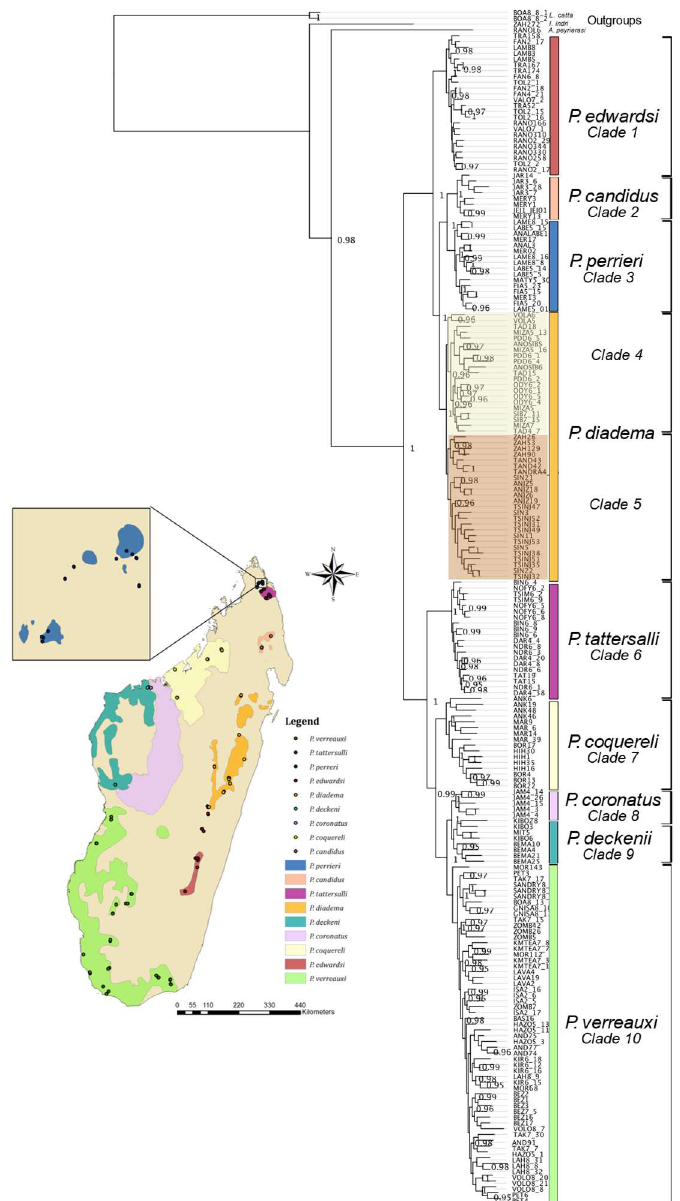
Figure 1. Distribution of all nine species of sifaka across Madagascar (range estimates obtained from IUCN, www.iucnredlist.org, accessed on 1 January 2020), with each individual included plotted in the matching color. Note the two clades within P. diadema are shown in light and darker orange shades. Phylogenetic tree generated in MrBayes from the 50 most informative UCEs. For simplicity, the major clades have been labelled as numbers 1–10 and colored the same across all figures.